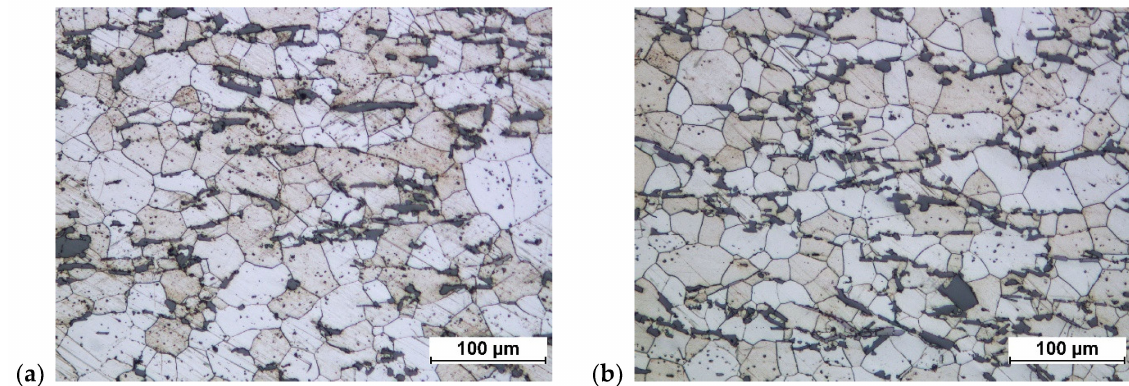
Figure 34. Connecting rod forging forged from a preform in accordance with variant 1: ( a ) on a crank press; ( b ) on a crank press and after heat treatment.